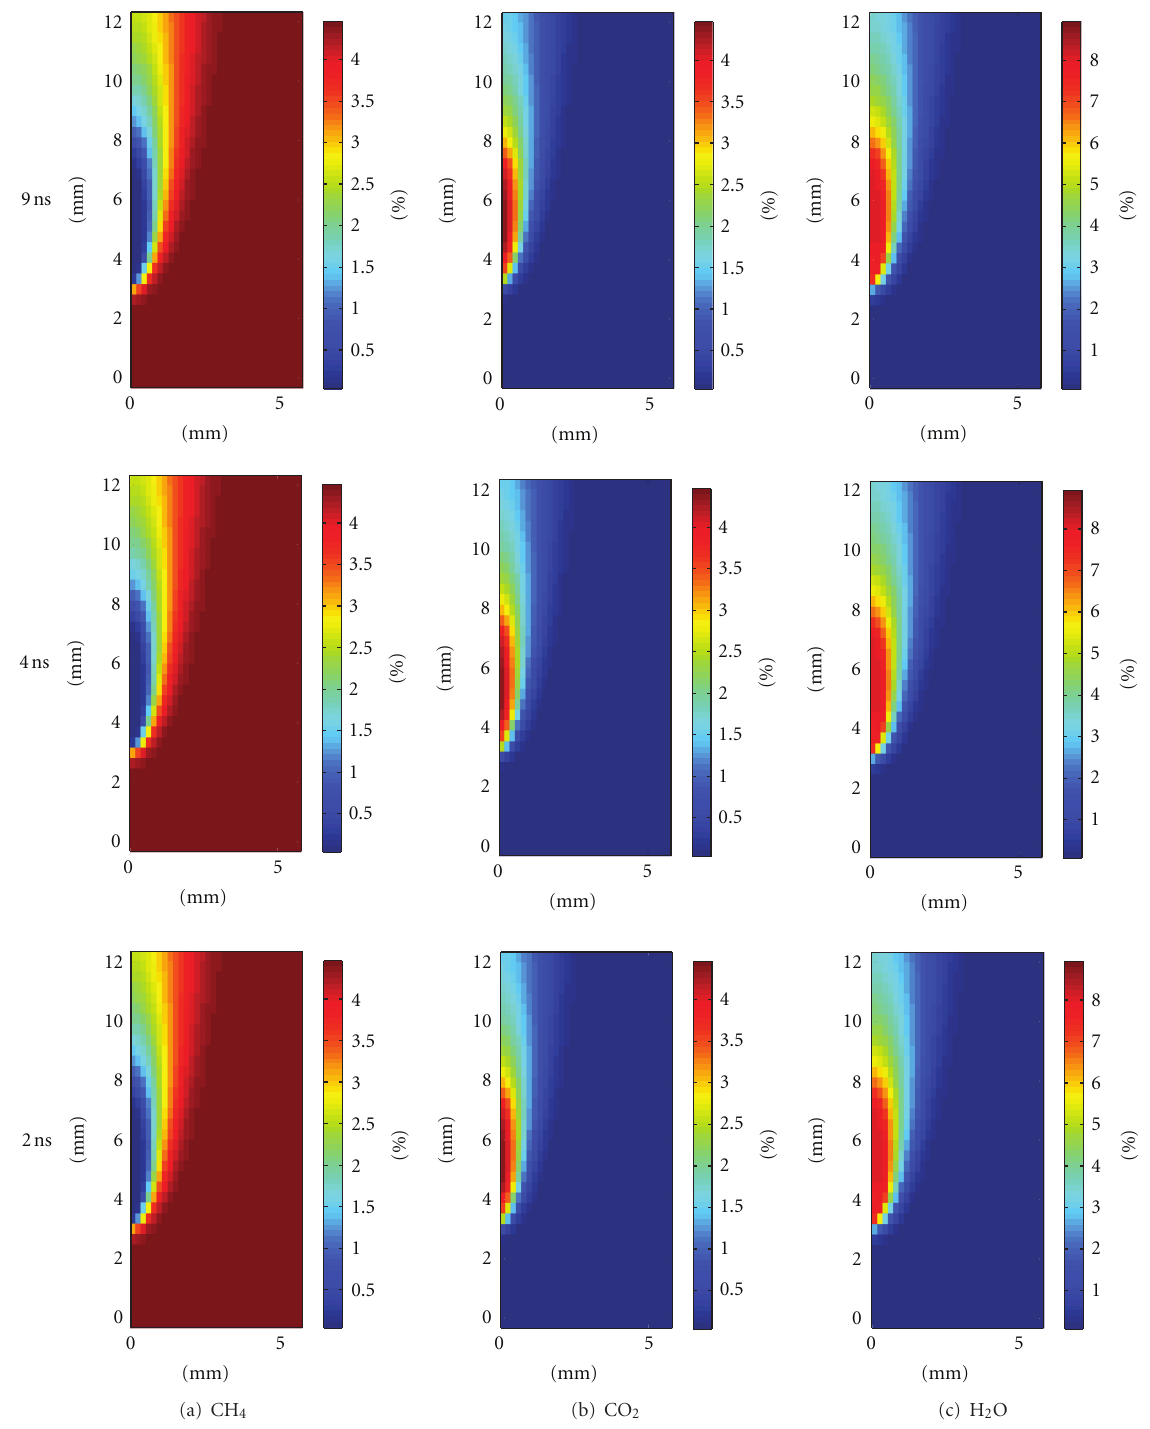
Figure 6: Quasi-steady state spatial distribution of (a) CH 4 , (b) CO 2 , and (c) H 2 O for three di ff erent pulse widths of 9 ns, 4ns, and 2ns at 30kHz repetition